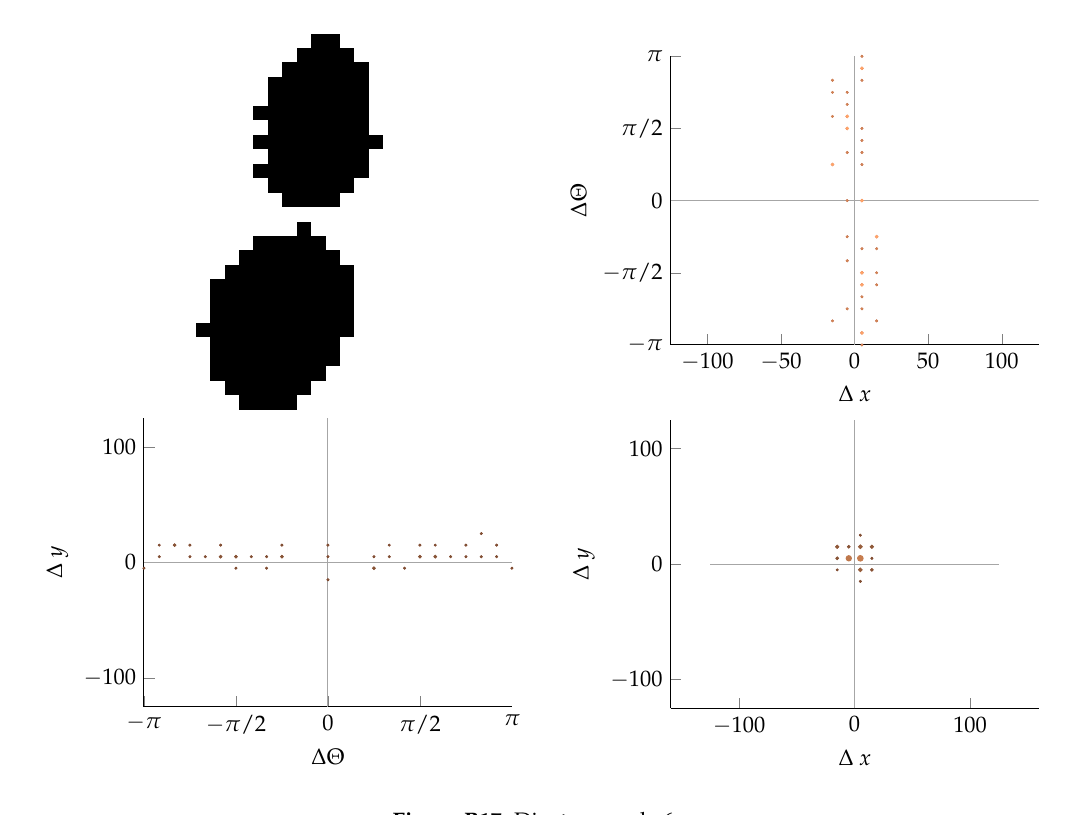
Figure B17. Dicot example